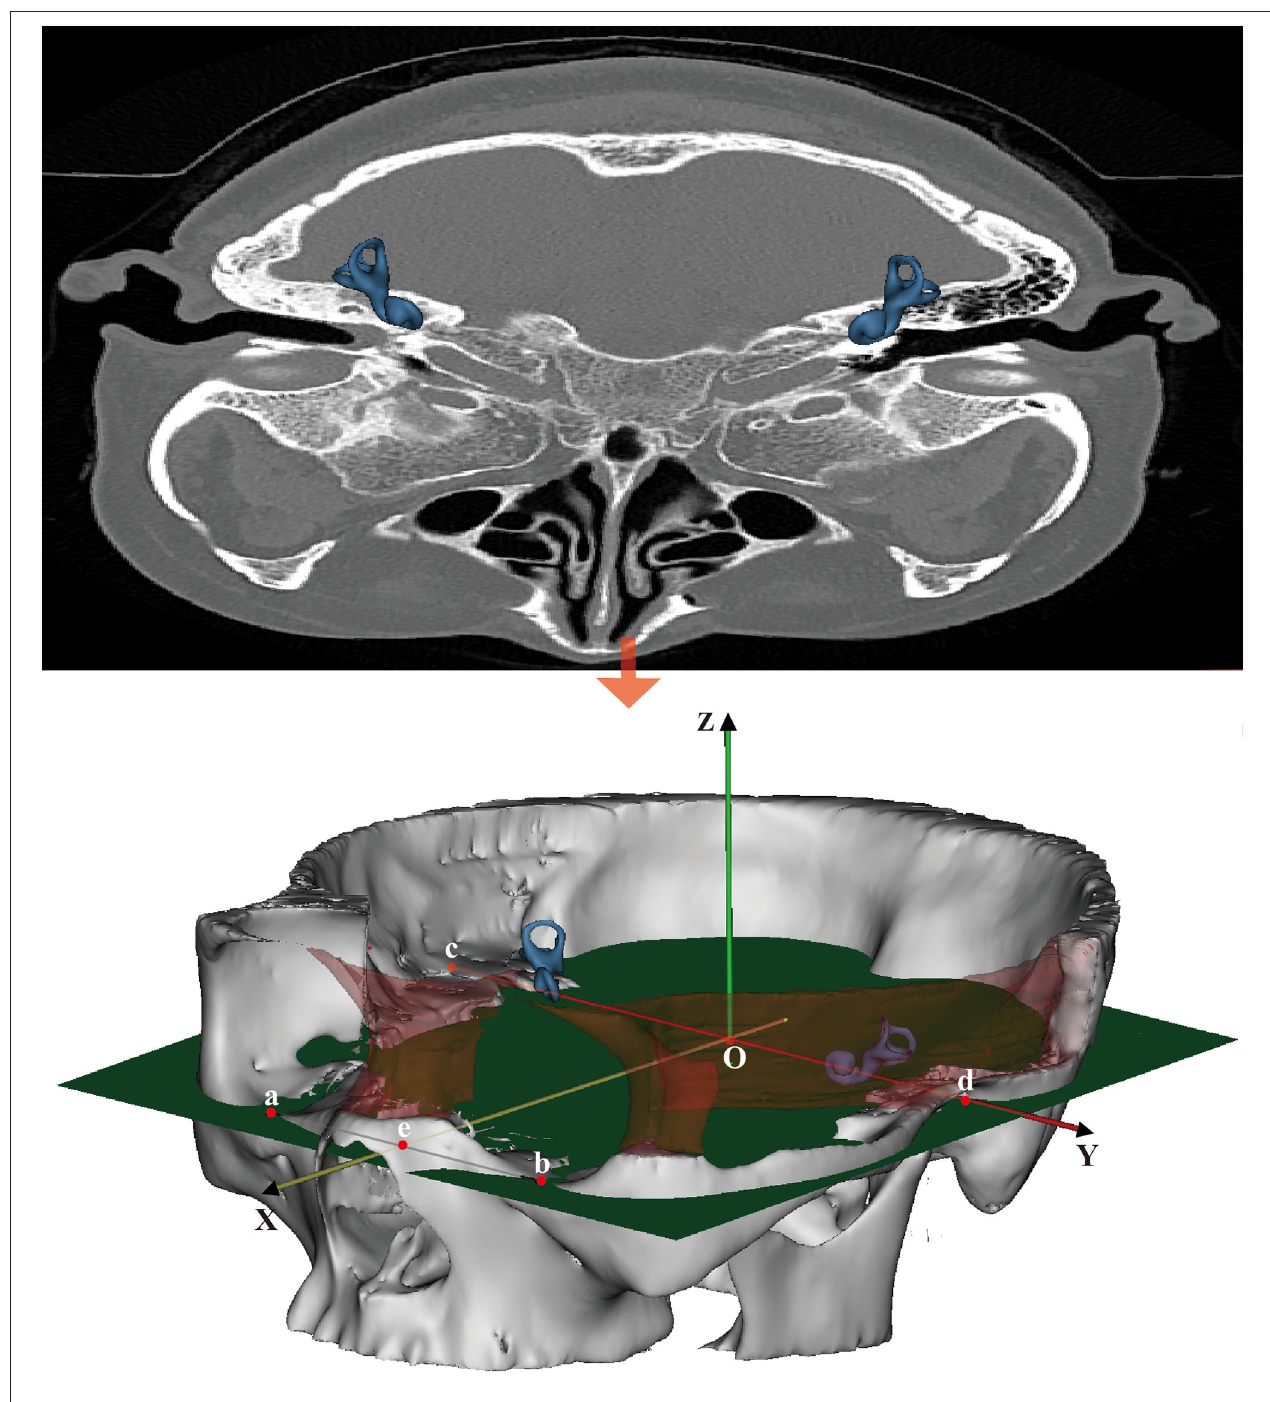
FIGURE 1 | Reid’s coordinate system overlaid on a CT image. Points a and b are the bilateral midpoints of the inferior margin of the orbits. Points c and d are the bilateral midpoints of the external auditory canal. Point e is the midpoint of the line segment ab. The origin of the coordinate system, point O, is the midpoint of line −→ −→ segment cd. The x- and y- axes are defined by the rays Oe and Od, respectively, and the z -axis is perpendicular to x and y ( + superior). The sagittal plane (SP) was defined as the plane that contains point O and is perpendicular to the y -axis.